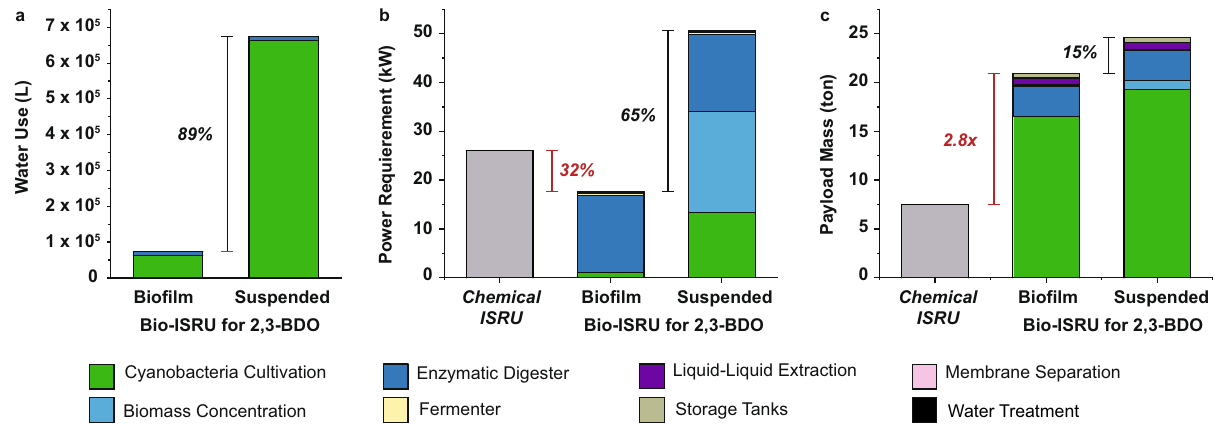
Fig. 6 Full process metrics for the bio-ISRU production of 2,3-BDO. a Water use, b power requirement, and c payload mass accounting for all unit operations in the bio-ISRU for 2,3-BDO production using either bio fi lm or suspended cyanobacteria growth modes. Results are based on 10 tons of 2,3- BDO produced over 500 sols. Chemical ISRU (DRA 5.0 O 2 only strategy) shown in gray. Source data are provided as a Source Data